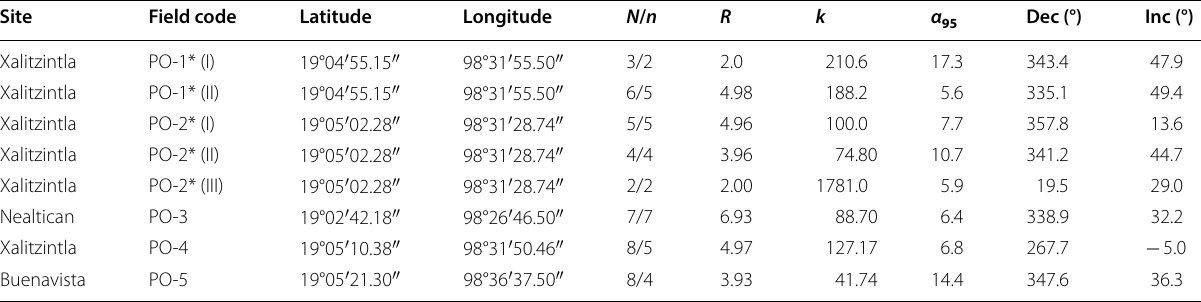
Sites with an asterisk denote pyroclastic density current (PDC) N number of recovered drill cores, n number of specimens used for the calculation of site‑mean direction, R unit vector sum, k precision parameter, α 95 95 per cent confidence level, Dec declination, Inc inclination